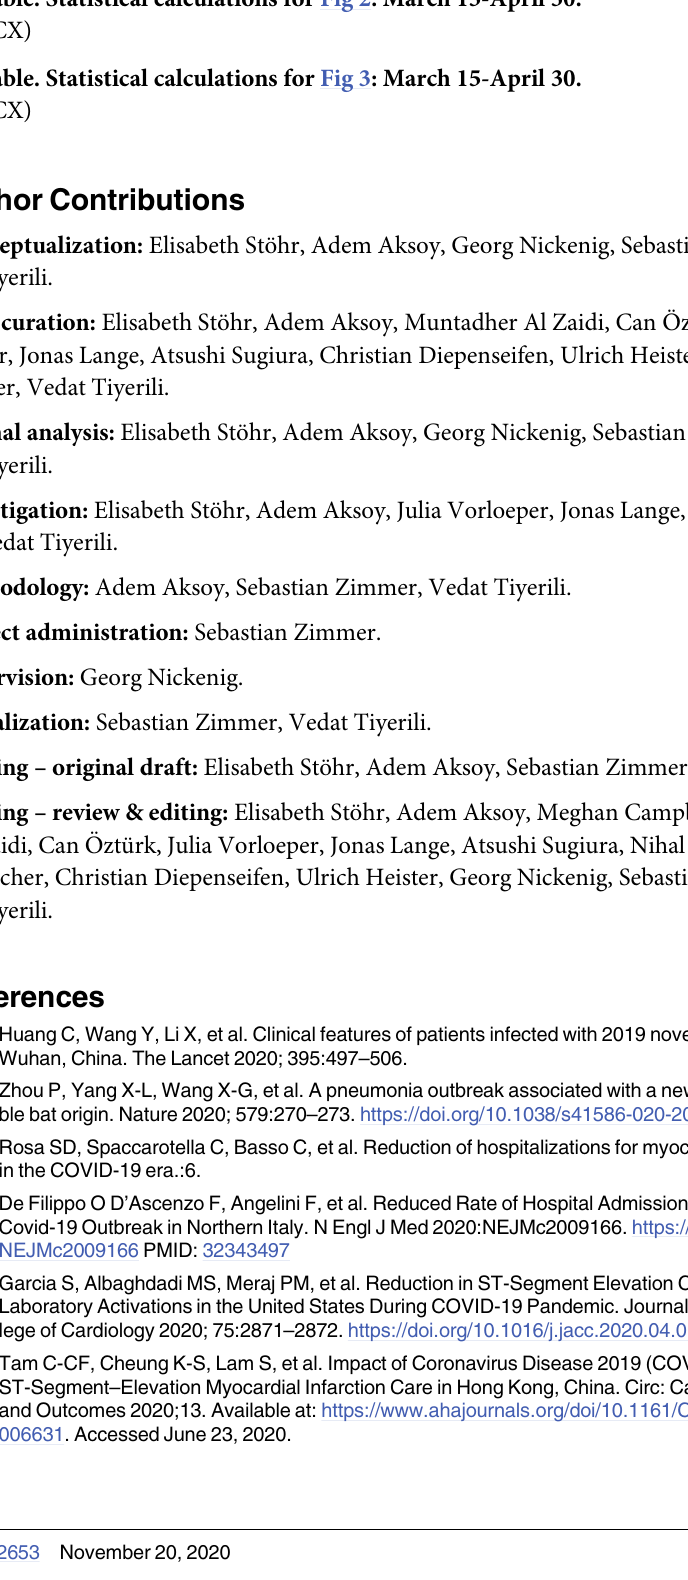
S1 Table. Statistical calculations for Fig 1: March 15-April 30. S2 Table. Statistical calculations for Fig 2: March 15-April 30. S3 Table. Statistical calculations for Fig 3: March 15-April